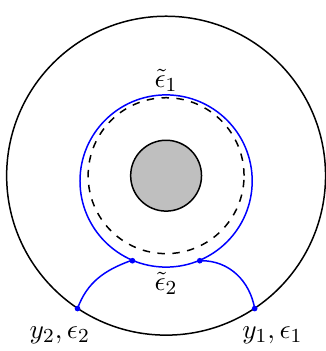
Figure 3 . The necklace graph on the annulus. The inner and outer black solid circles represent the conformal boundary. The blue dashed circle goes along the r = 0 radius and corresponds to the 0-point block. The blue solid loop is a deformation of the dashed circle by external